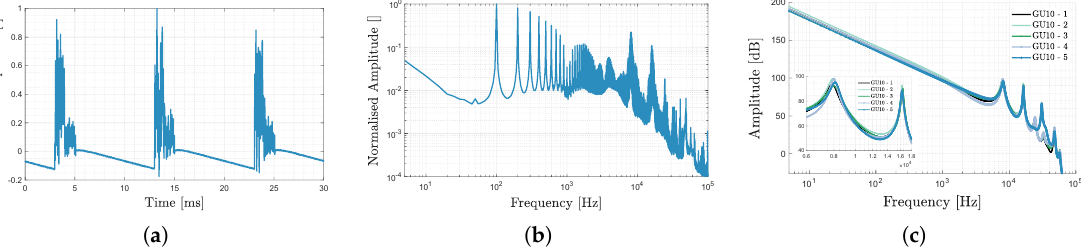
Figure 2. KLLUG-511 appertaining ( a ) mean-subtracted normalised V PD , i ( t ) time domain waveform, ( b ) first harmonic-normalised fast Fourier transform (FFT) spectrum and ( c ) MUSIC’s output pseudospectrum for 5